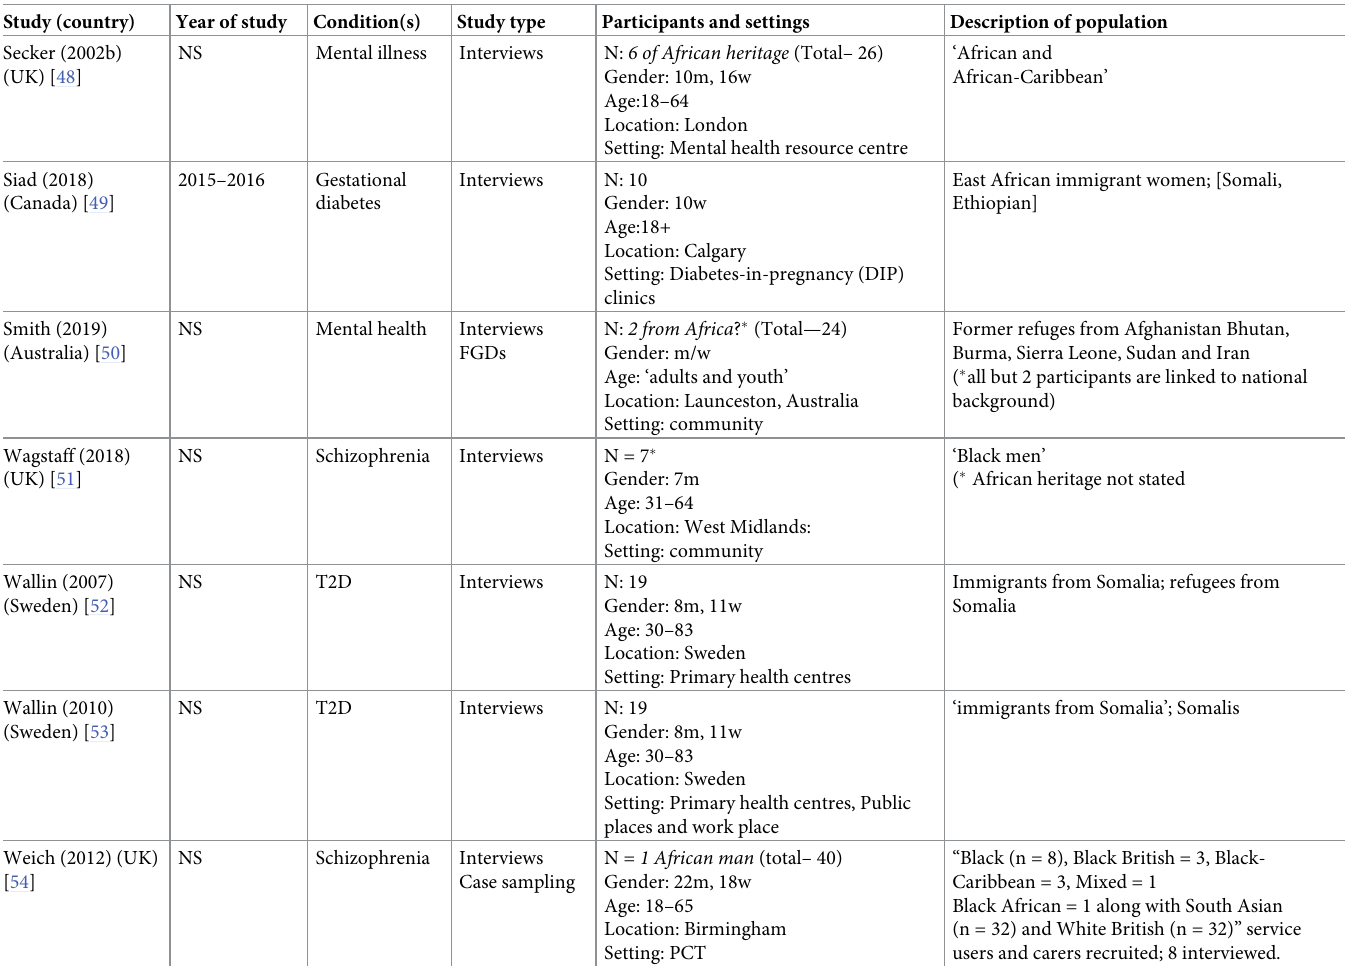
with linguistic competence. Table 2 captures the nuances of participant descriptions, focusing on countries and immi- gration status of participants, for studies that provide this data. Full details are provided in Tables 1 and